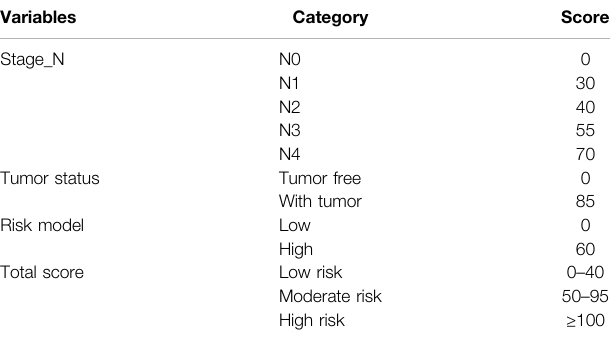
TABLE 2 | Corresponding risk score for each variable and total score.